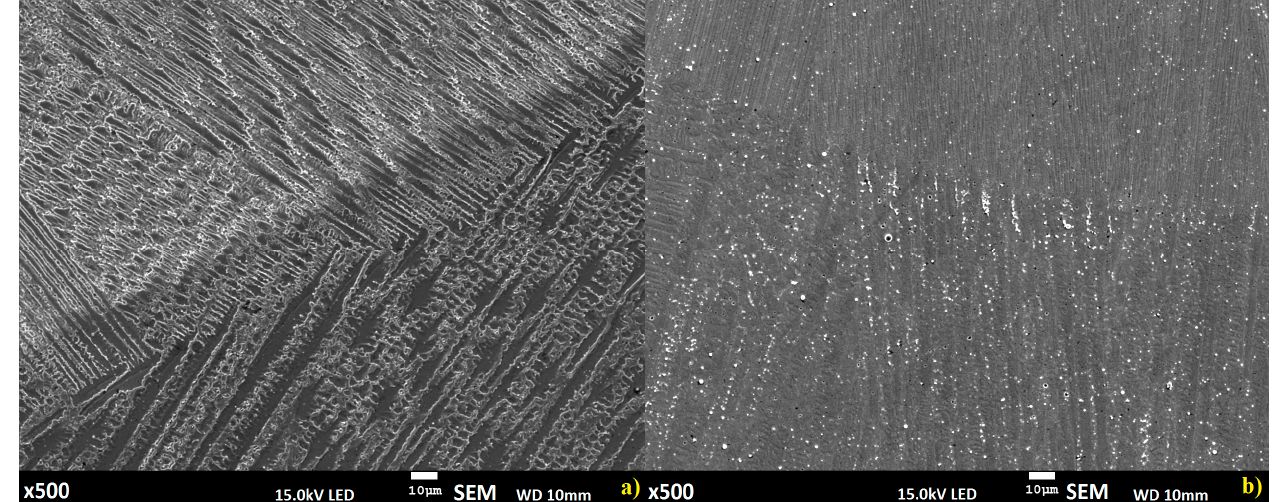
Figure 8. Microstructure of the interlayer zone between the second and third layers for: ( a ) wire deposition method, ( b ) semi-hybrid deposition method.